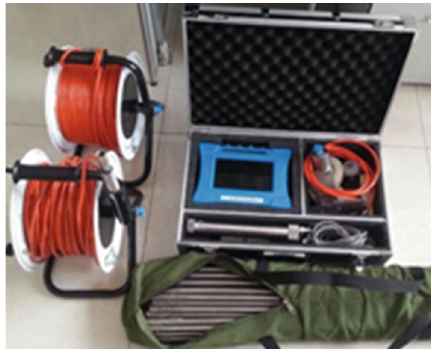
Figure 9: RBIT-30 borehole